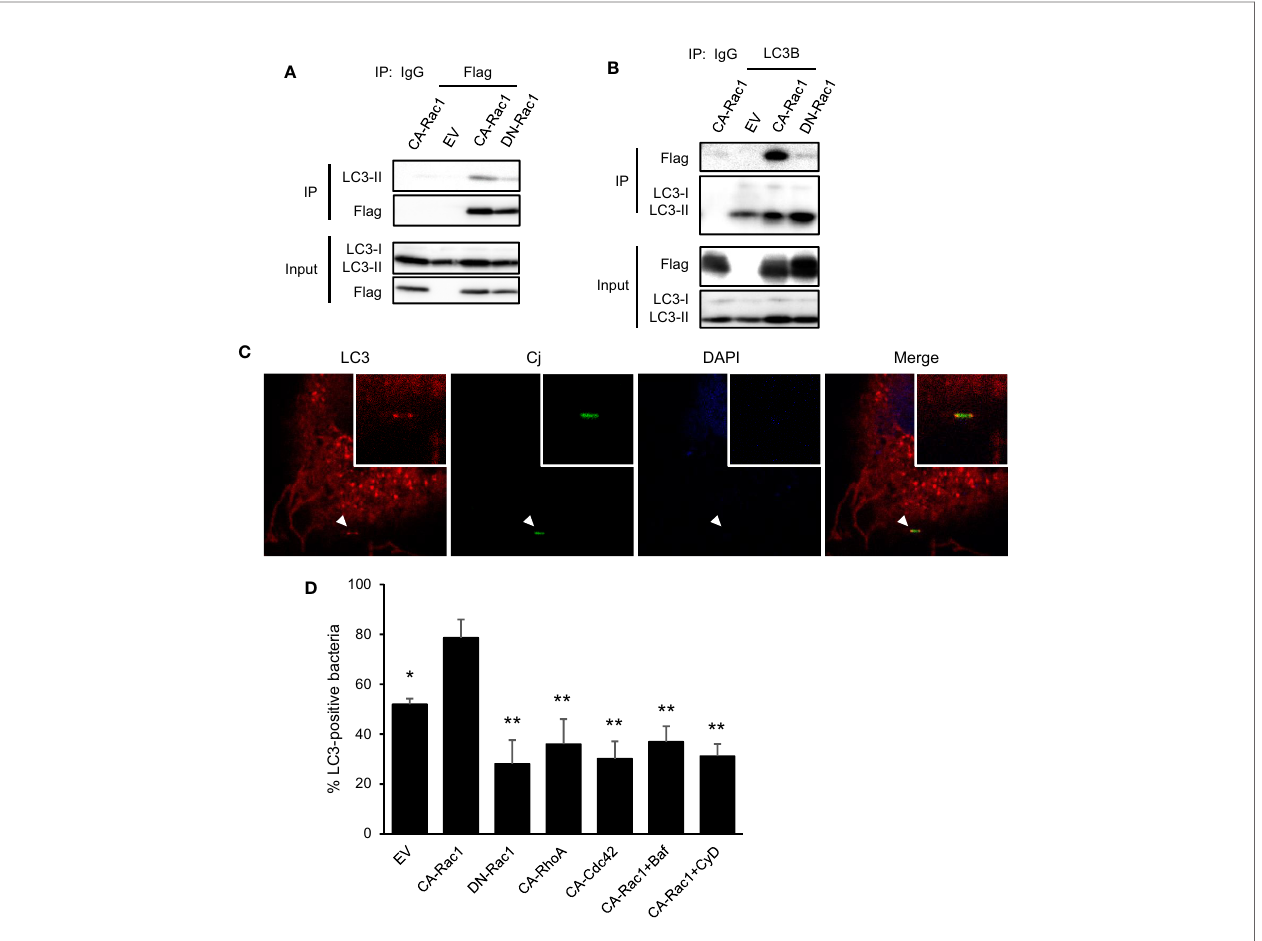
FIGURE 4 | Interaction of autophagy signaling and Rac1 signaling in C. jejuni infection. (A) HeLa cells were transfected with EV, CA-Rac1, and DN-Rac1. Cells were lysed and subjected to immunoprecipitation with Sepharose beads, and analyzed by Western blotting by using anti-Flag antibody. (B) HeLa cells were transfected with vectors as shown, and subjected to immunoprecipitation. Cell lysates were analyzed by Western blotting by using anti-LC3B antibody. (C) Representative immuno fl uorescence images of CA-Rac1 expressed HeLa cells infected with C. jejuni which stained with 10 ng/ml 5(6)-Carboxy fl uorescein diacetate (CFDA) solution. Cells were immunostained by anti-LC3 antibody and DAPI, and observed by confocal microscope. (D) The rate of colocalization of C. jejuni and LC3 was quanti fi ed in EV, CA-Rac1, DN-Rac1, CA-RhoA, and CA-Cdc42 expressed HeLa cells. CA-Rac1 transfected cells were treated with 200 nM Ba fi lomycin A1 (Baf) for 3 h or 300 nM Cytochalasin D (CyD) for 1 h before infection. The differences of signni fi cance were tested in comparison with CA-Rac1. EV: n = 48, CA-Rac1: n = 73, DN-Rac1: n = 59, CA-RhoA: n = 65, CA-Cdc42: n = 83, CA-Rac1 + Baf: n = 55, CA-Rac1 + CyD: n = 51 of bacterial cells. The data of confocal microscope were pooled from 4 independent experiments. Differences were evaluated with Two-tailed Student ’ s t-test. * p < 0.05, ** p <